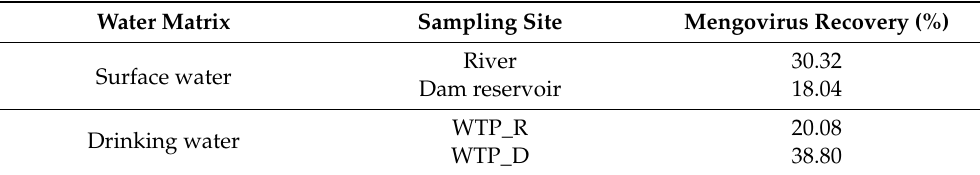
Table 1. Mengovirus recovery rates in the water samples collected in the 2018 pilot sampling ( n = 4) (addition of mengovirus after the filtration/primary concentration